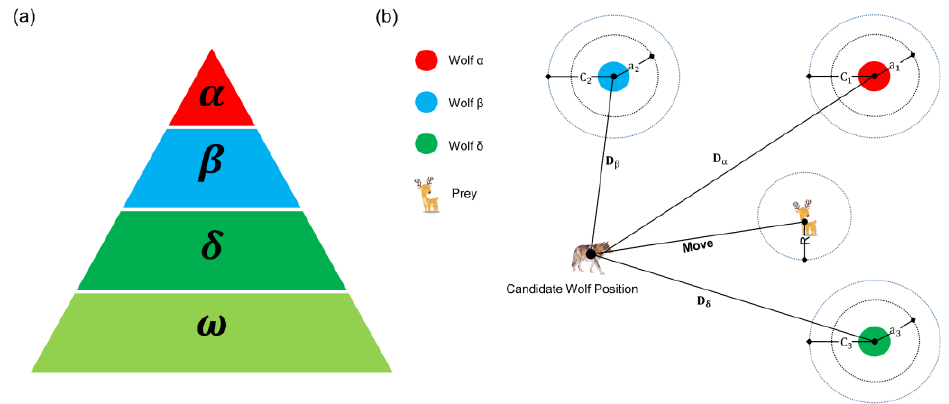
Figure 2. The intro-diagrams of GWO including ( a ) the social hierarchy of grey wolf pack (domi- nance decreases from top down) and ( b ) diagram of the hunting mechanism, as well as the grey wolf position updating process. “Readapted with permission from Ref. [25]. 2022, Elsevier ”